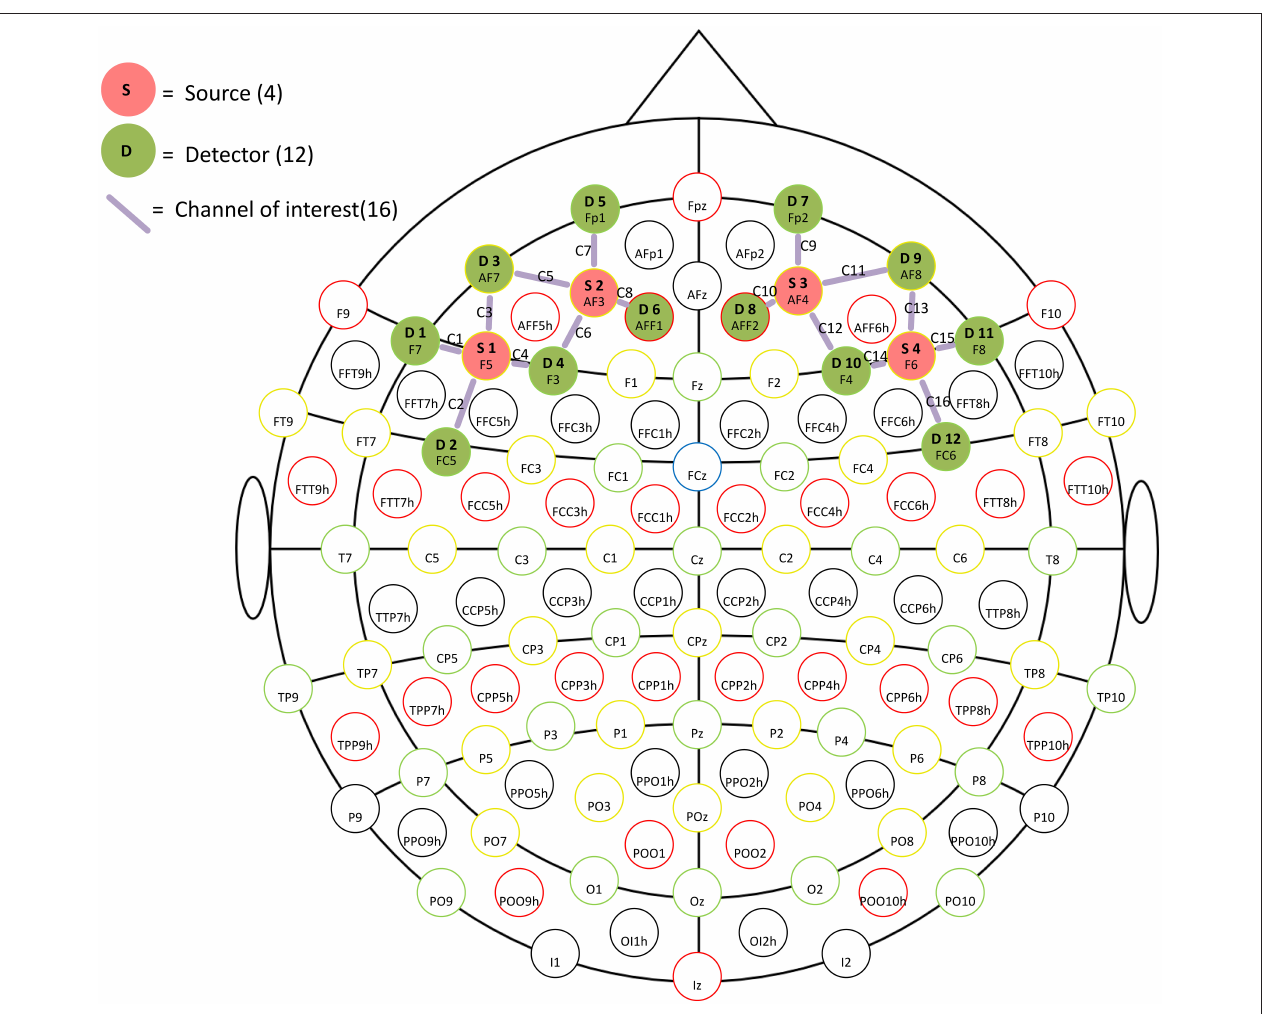
FIGURE 1 | The head probe placed on the forehead. The letters D and S represent the detectors and light source, respectively. The mauve lines with the letter C represent channels.